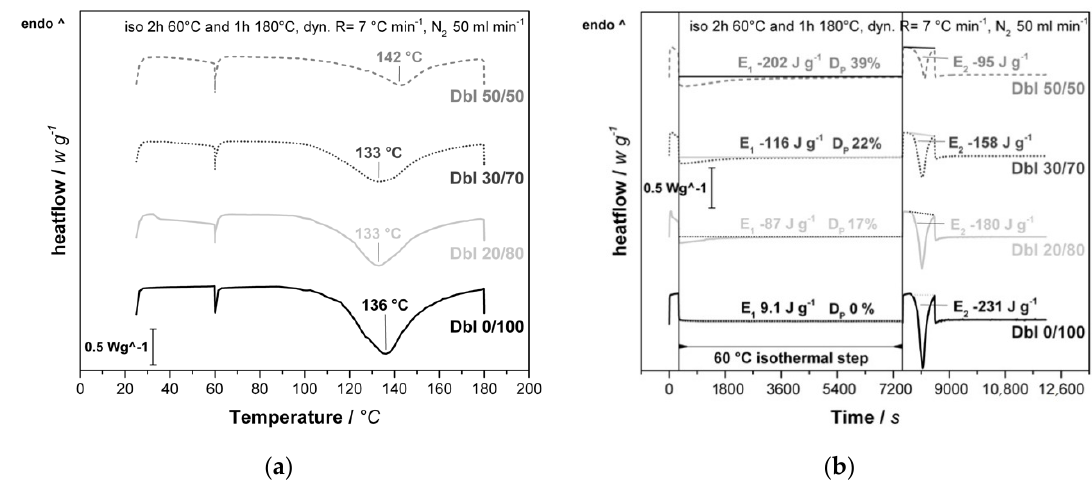
Figure 3. Results from the process-related DSC analysis of DbI systems with an IPDA/B-IPDA blend ratio of 0/100 w , 20/80 w , 30/70 w and 50/50 w . ( a ) DSC thermograms plotted against temperature with indicated peak temperatures. ( b ) DSC thermograms with indicated peak energies (E 1 and E 2 ) and resulting pre-curing degree (D P ) plotted against time with indicated 60 °C isothermal step for pre-curing.